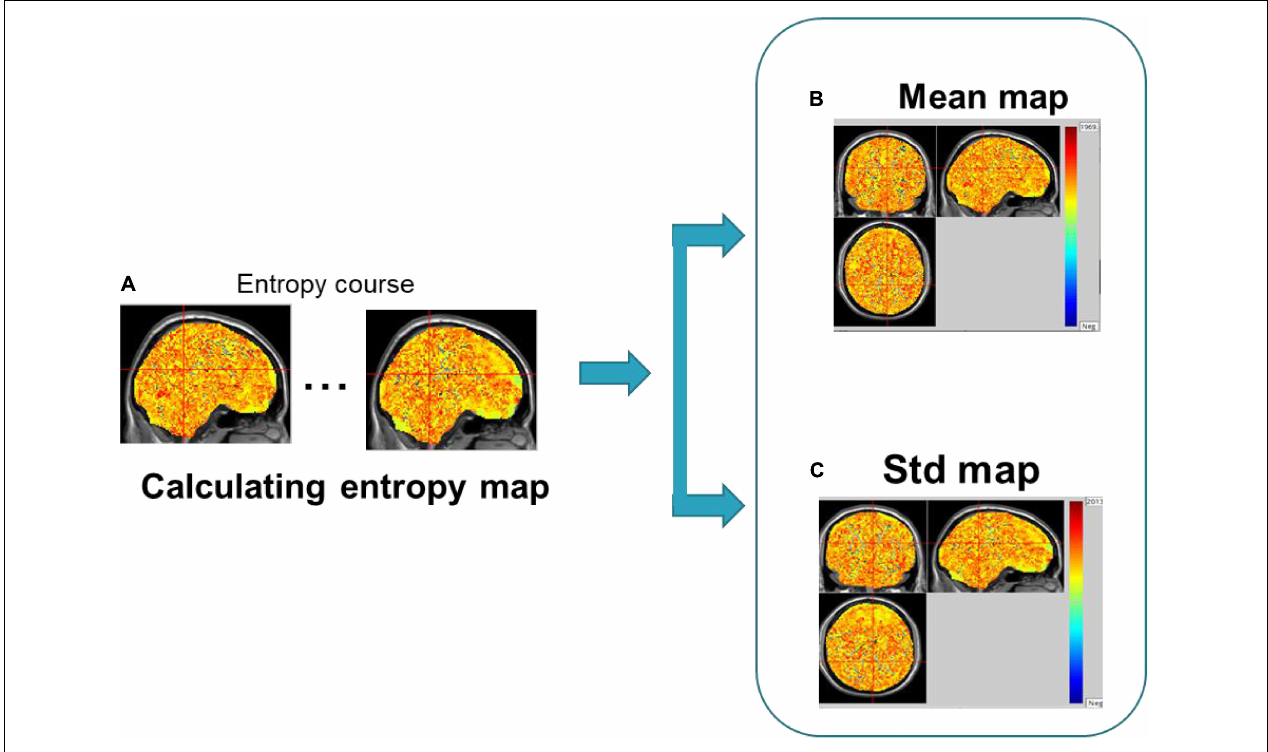
FIGURE 2 | Framework of dynamical brain entropy mapping analysis.